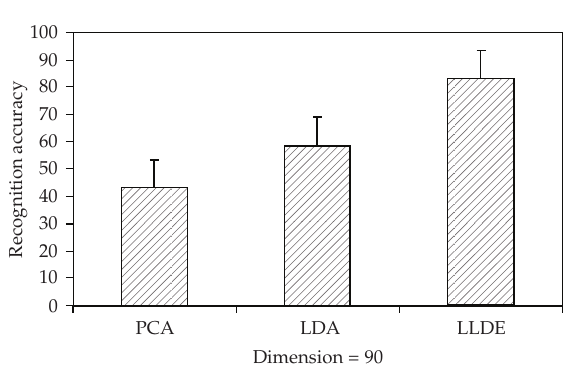
Figure 6: The average recognition rates of the PCA, LDA, and LLDE across 10 tests (cid:2) dimension 90 (cid:3) .